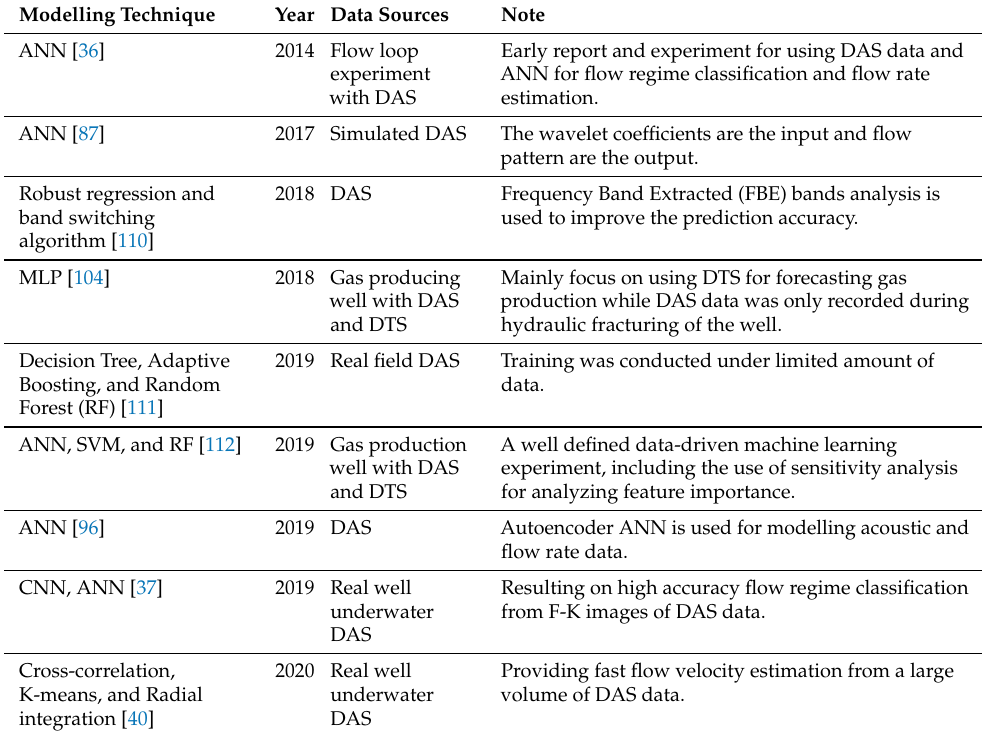
Table 2. Comparison of machine learning algorithms on using distributed fibre optic sensors for flow rate estimation and multiphase